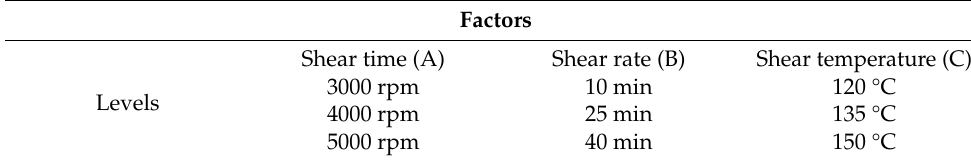
Table 3. The factor and levels table of the orthogonal experiment.